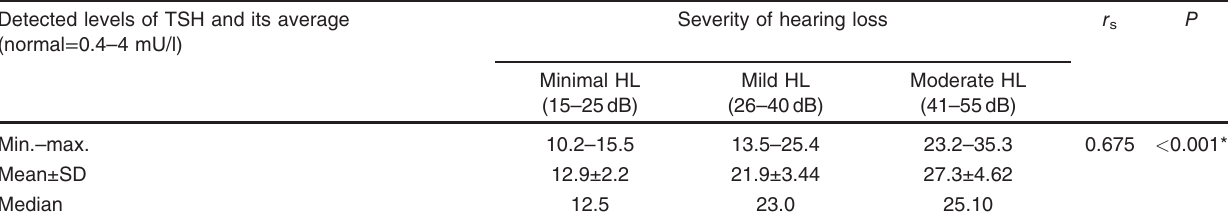
Table 5 Correlation between the severity of hearing loss and the levels of the relevant thyroid-stimulating hormone among 54 ears with hearing impairment Detected levels of TSH and its average (normal = 0.4 – 4 mU/l)